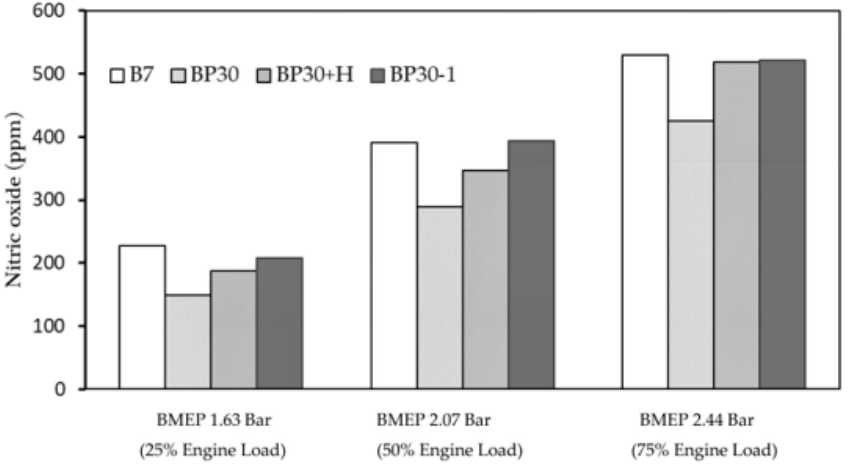
Figure 15. Effects of fuel enhancement on nitric oxide